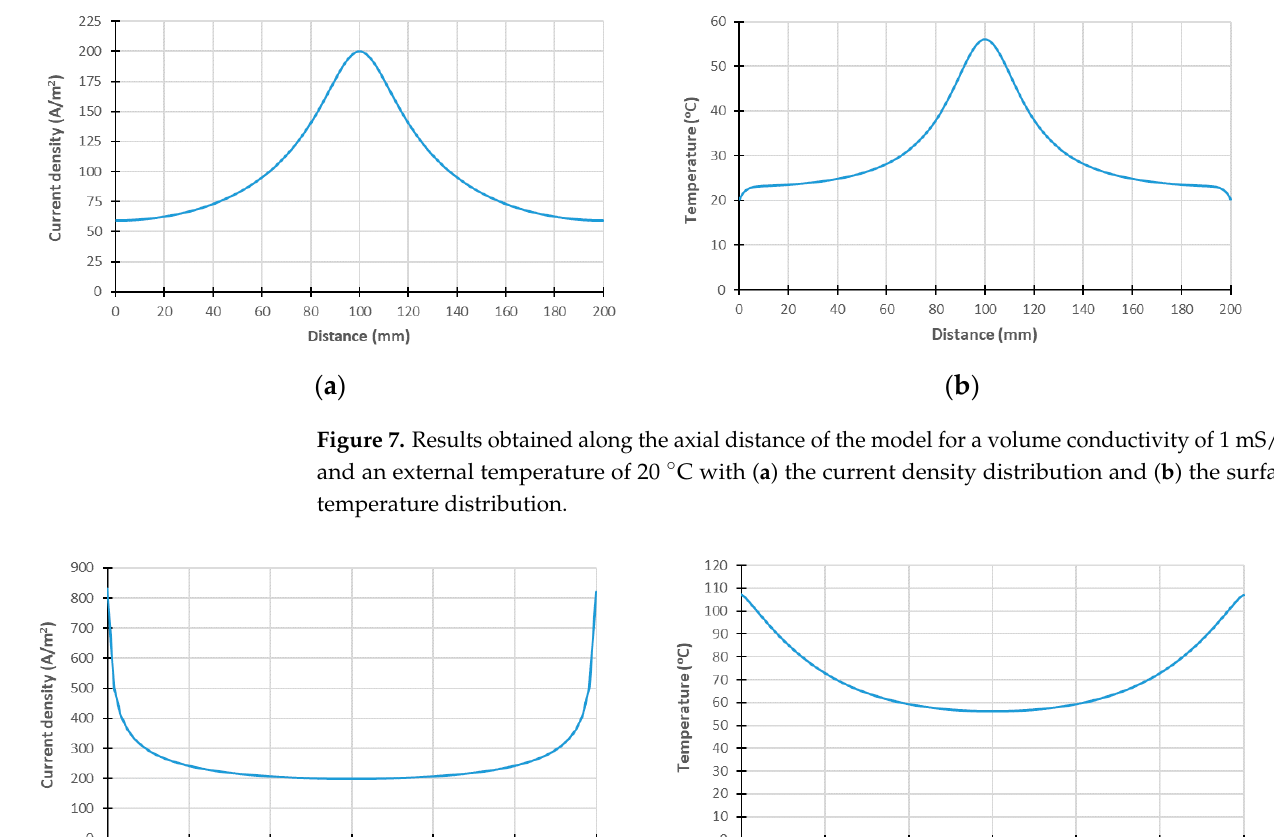
Figure 6. Thermoelectric simulation of the proposed geometry for a surface conductivity of 1 mS/m and an external temperature of 20 °C with ( a ) current line distribution represented by the red arrows and an external temperature of 20 ◦ C with ( a ) current line distribution represented by the red arrows and ( b ) surface temperature distribution. and ( b ) surface temperature distribution.